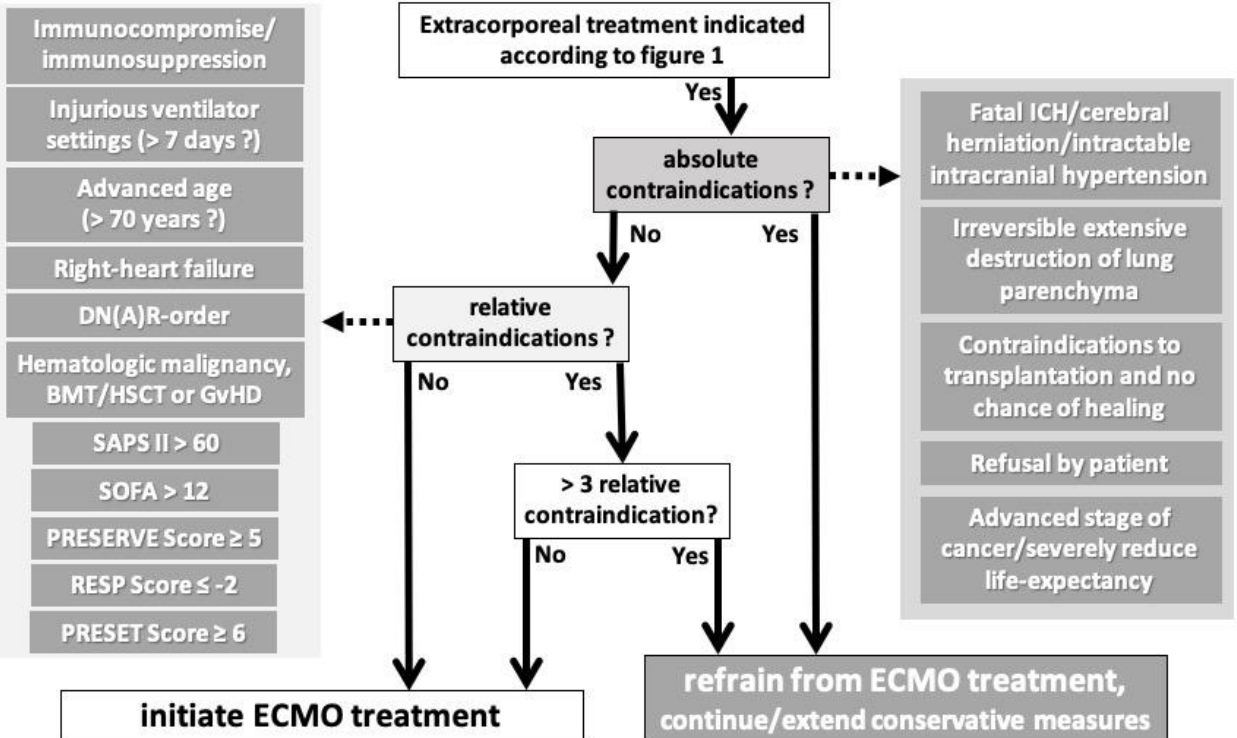
Figure 3. Algorithm to include contraindications in the process of initiation of ECMO treatment after the indication has been confirmed according to Figure 1. Abbreviations: DN(A)R = do not attempt resuscitation, SAPS II = Simplified Acute Physiology Score first revision, SOFA = Sepsis-Related/Sequential Organ Failure Assessment, PRESERVE = Predicting Death of Severe ARDS on vvECMO, RESP = Respiratory Extracorporeal Membrane Oxygenation Survival Prediction, PRESET = Prediction of Survival on ECMO Therapy, BMT = bone marrow transplantation, HSCT = human stem-cell transplantation, GvHD = graft-versus-host disease, ICH = intracranial hemorrhage, ECMO = extracorporeal membrane oxygenation.